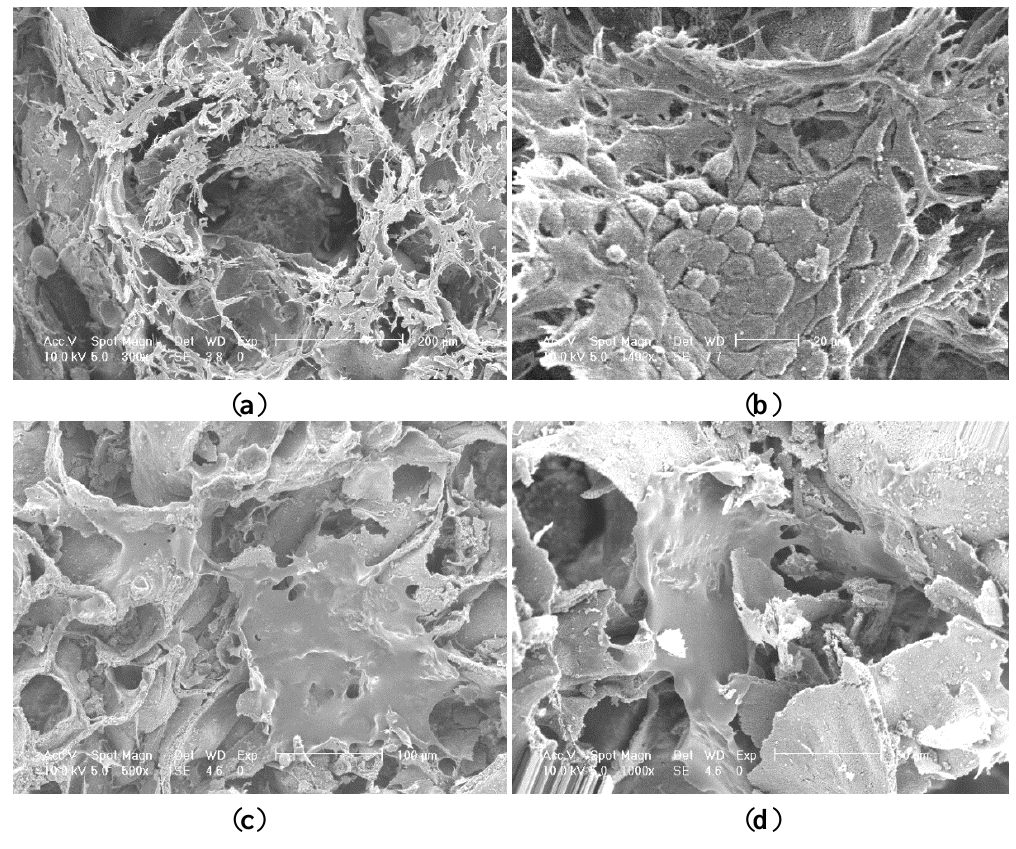
Figure 6. SEM micrographs cell layer formation ( a ) phosphate showing migration of cells into porous network; ( b ) phosphate showing morphology of confluent layer at high magnification with squamous appearance; ( c ) silica showing two cell monolayers spanning across pore openings; ( d ) silica showing two monolayer of cells migrating towards each other along the wall of the silica doped